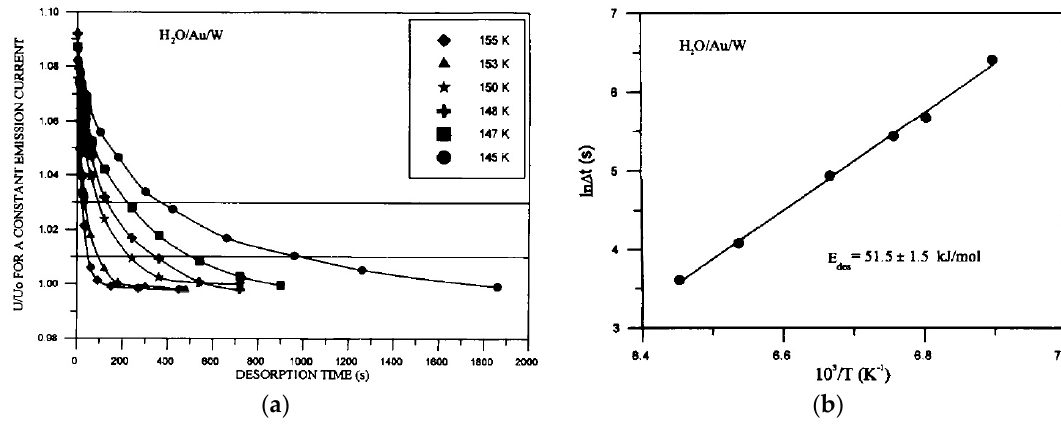
Figure 16. Extracting kinetic parameters from FEM analysis: ( a ) Thermal desorption isotherms of water from the Au-covered W tip in the temperature range 145–155 K to probe the desorption energy of the first water-adsorbed configuration; ( b ) Arrhenius plot obtained from ( a ). Reprinted from [137]. Copyright 1997, Elsevier.